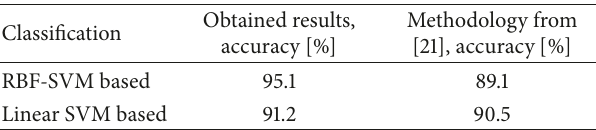
Table 2: The comparison